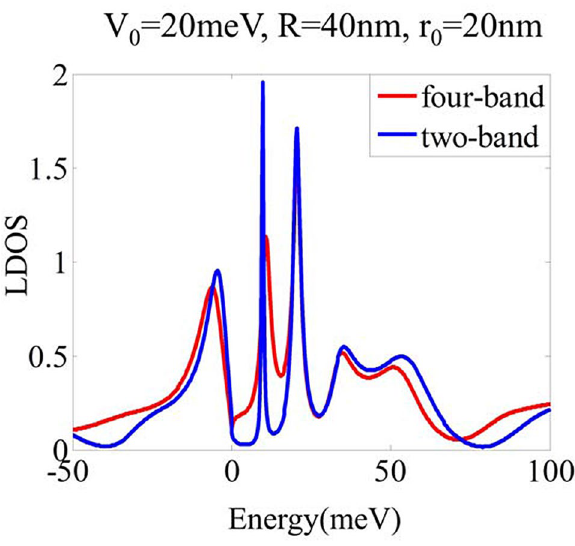
Figure 5. Comparison of the LDOS as functions of energy derived from the two-band and four-band